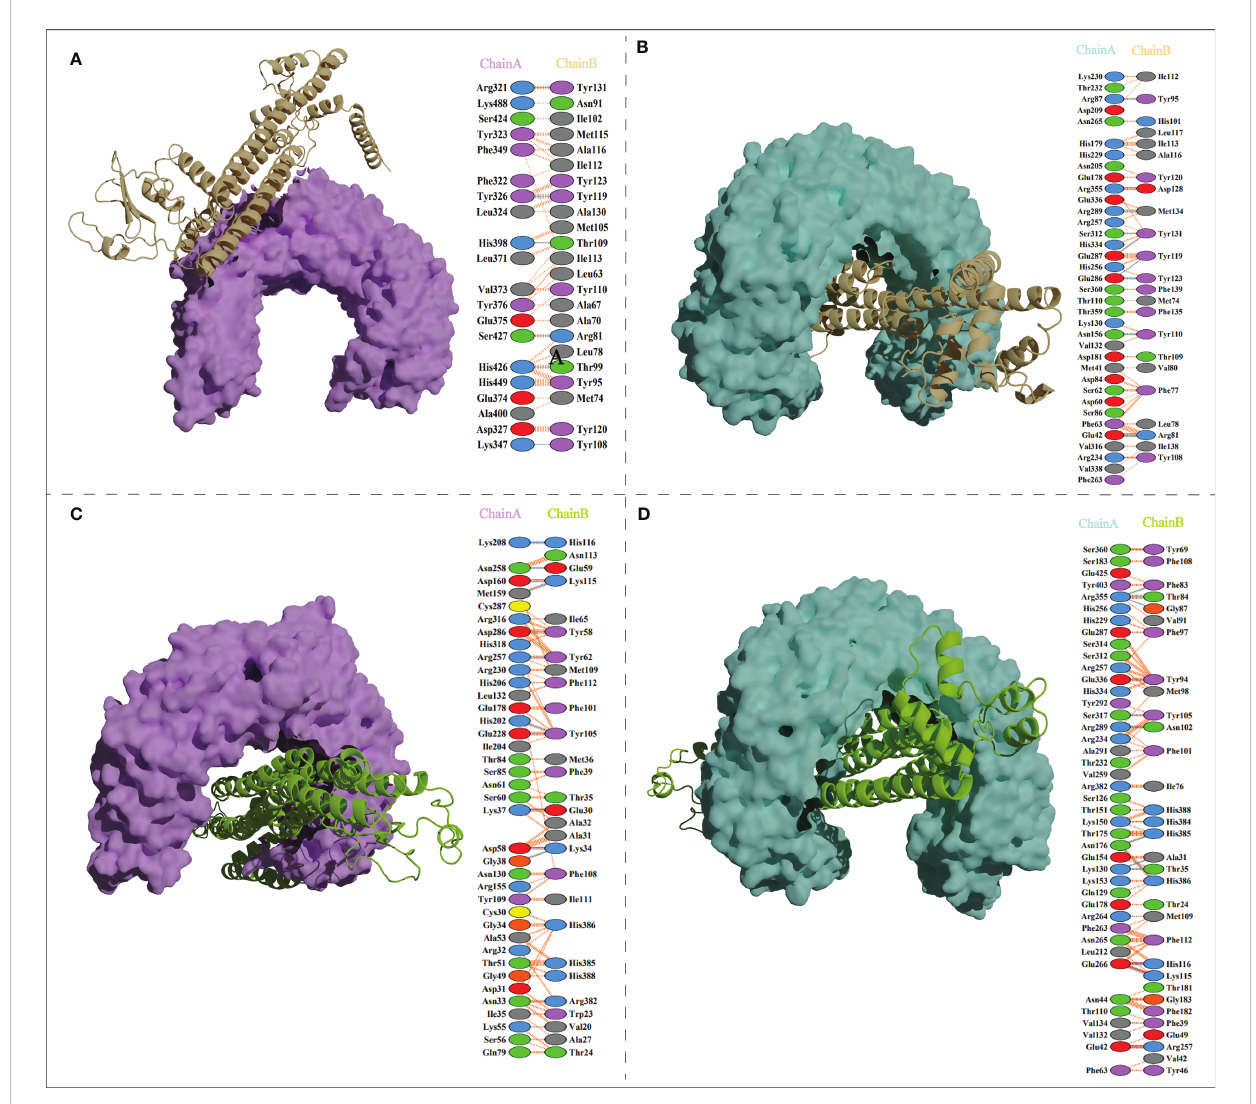
FIGURE 5 Vaccine candidates (MPXV-2 and MPXV-5) docked with TLR2 and TLR4. (A) The binding mode between the MPXV-2 and TLR2 and the interacting residues of the MPXV-2 with TLR2; (B) The binding mode between the MPXV-2 and TLR4 and the interacting residues of the MPXV-2 with TLR4; (C) The binding mode between the MPXV-5 and TLR2 and the interacting residues of the MPXV-5 with TLR2; (D) The binding mode between the MPXV-5 and TLR4 and the interacting residues of the MPXV-5 with